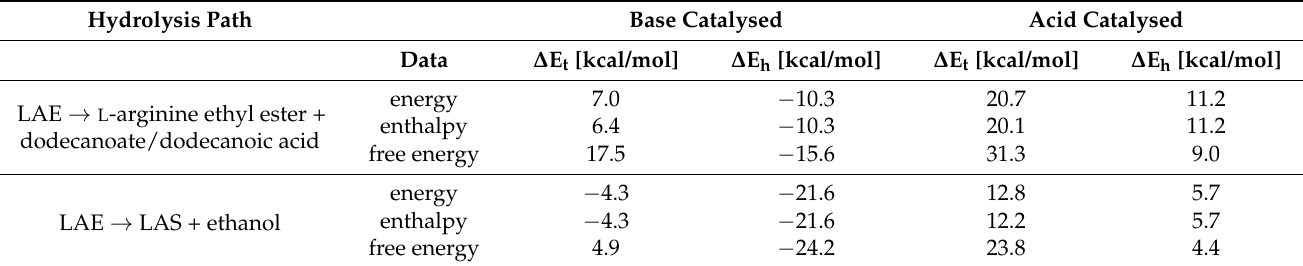
Table 2. Energies, enthalpies and free energies of LAE hydrolysis reactions Δ E h . and their transition states Δ E t . Hydrolysis Path Base